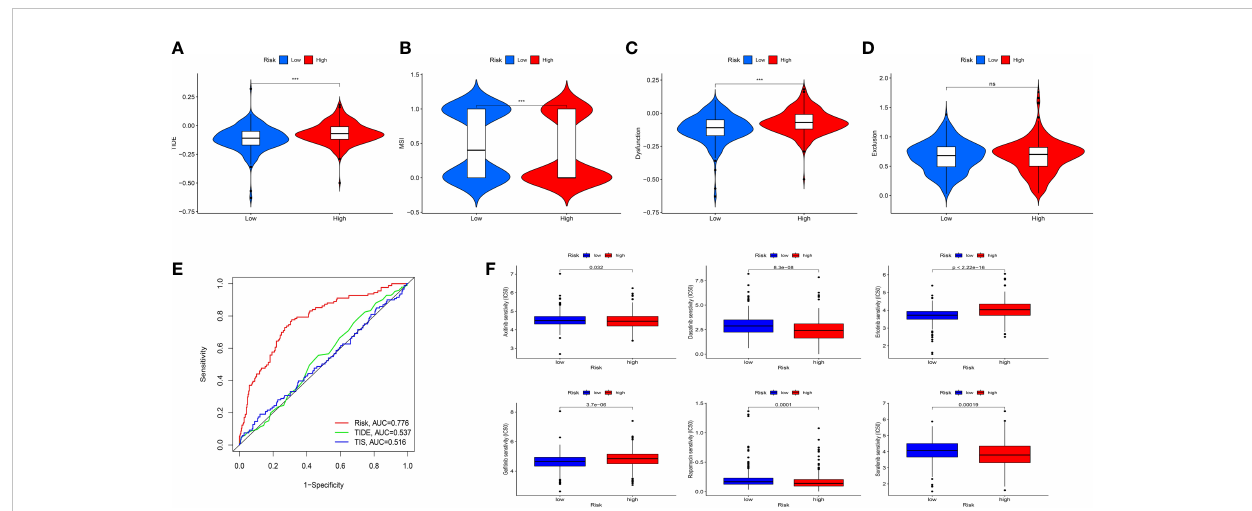
FIGURE 9 Evaluation the value of the IRFs-related prognostic model in immunotherapy and drug sensitivity. (A-D) Differences in TIDE, MSI, T cell dysfunction and T cell exclusion between the low- and high-risk groups. (E) ROC curve of IRFs-related prognostic model, TIDE and TIS in predicting the OS. (F) Correlation between risk score and drug sensitivity. *** p <0.001. ns, no signi fi